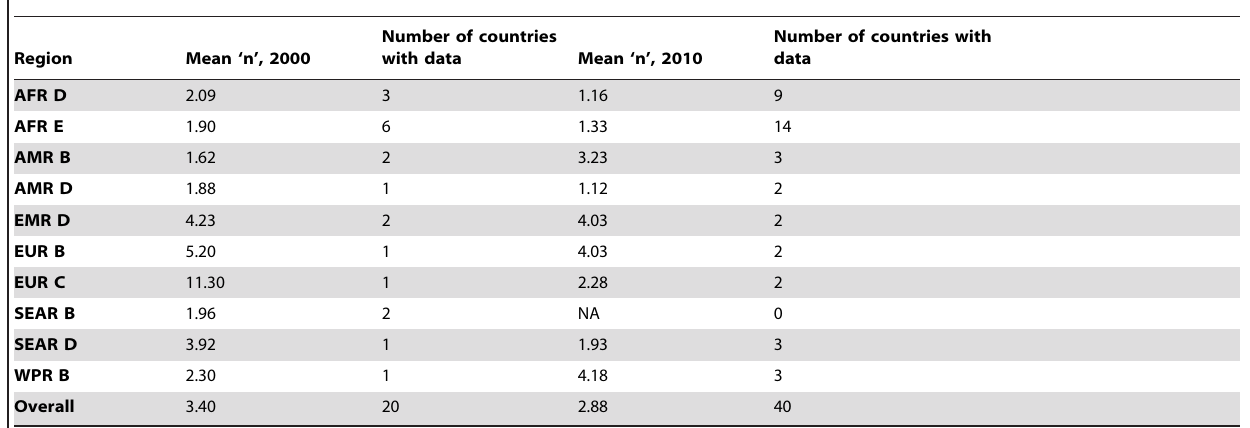
Table 2. Number of healthcare injections per person per year (‘n’) in each region, 2000 and 2010.